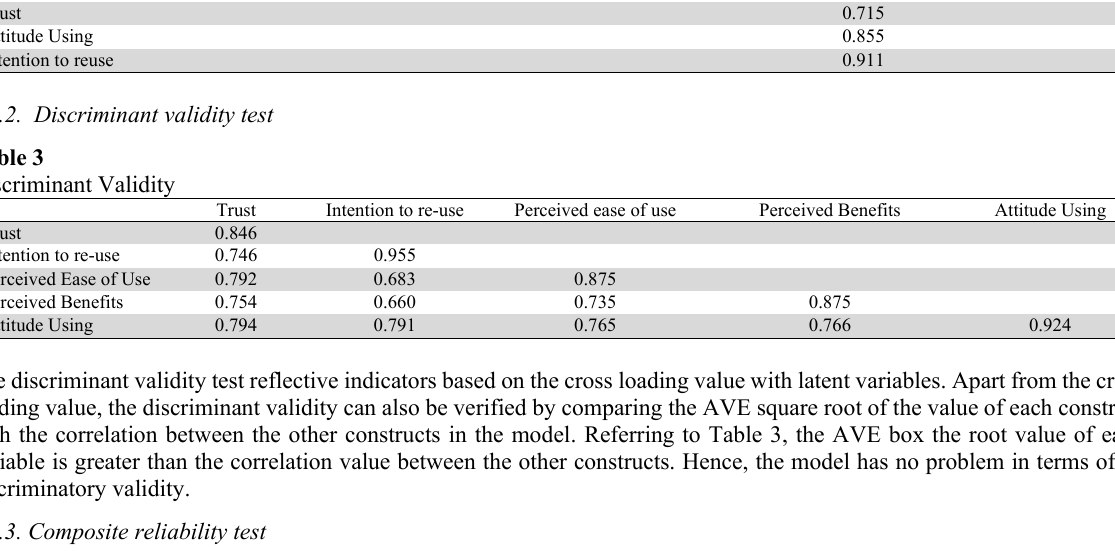
Average Variance Extracted (AVE) Variable Perceived Ease of Use